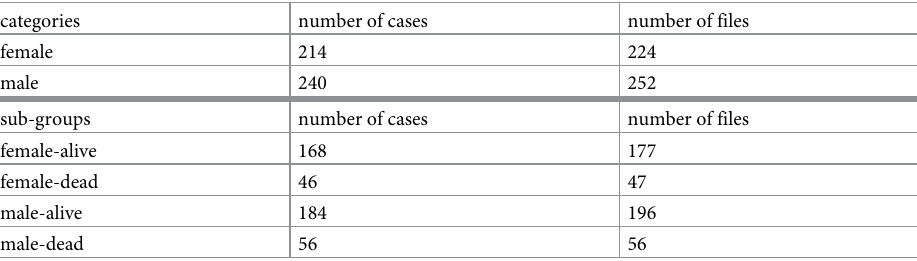
Table 3. Data set for